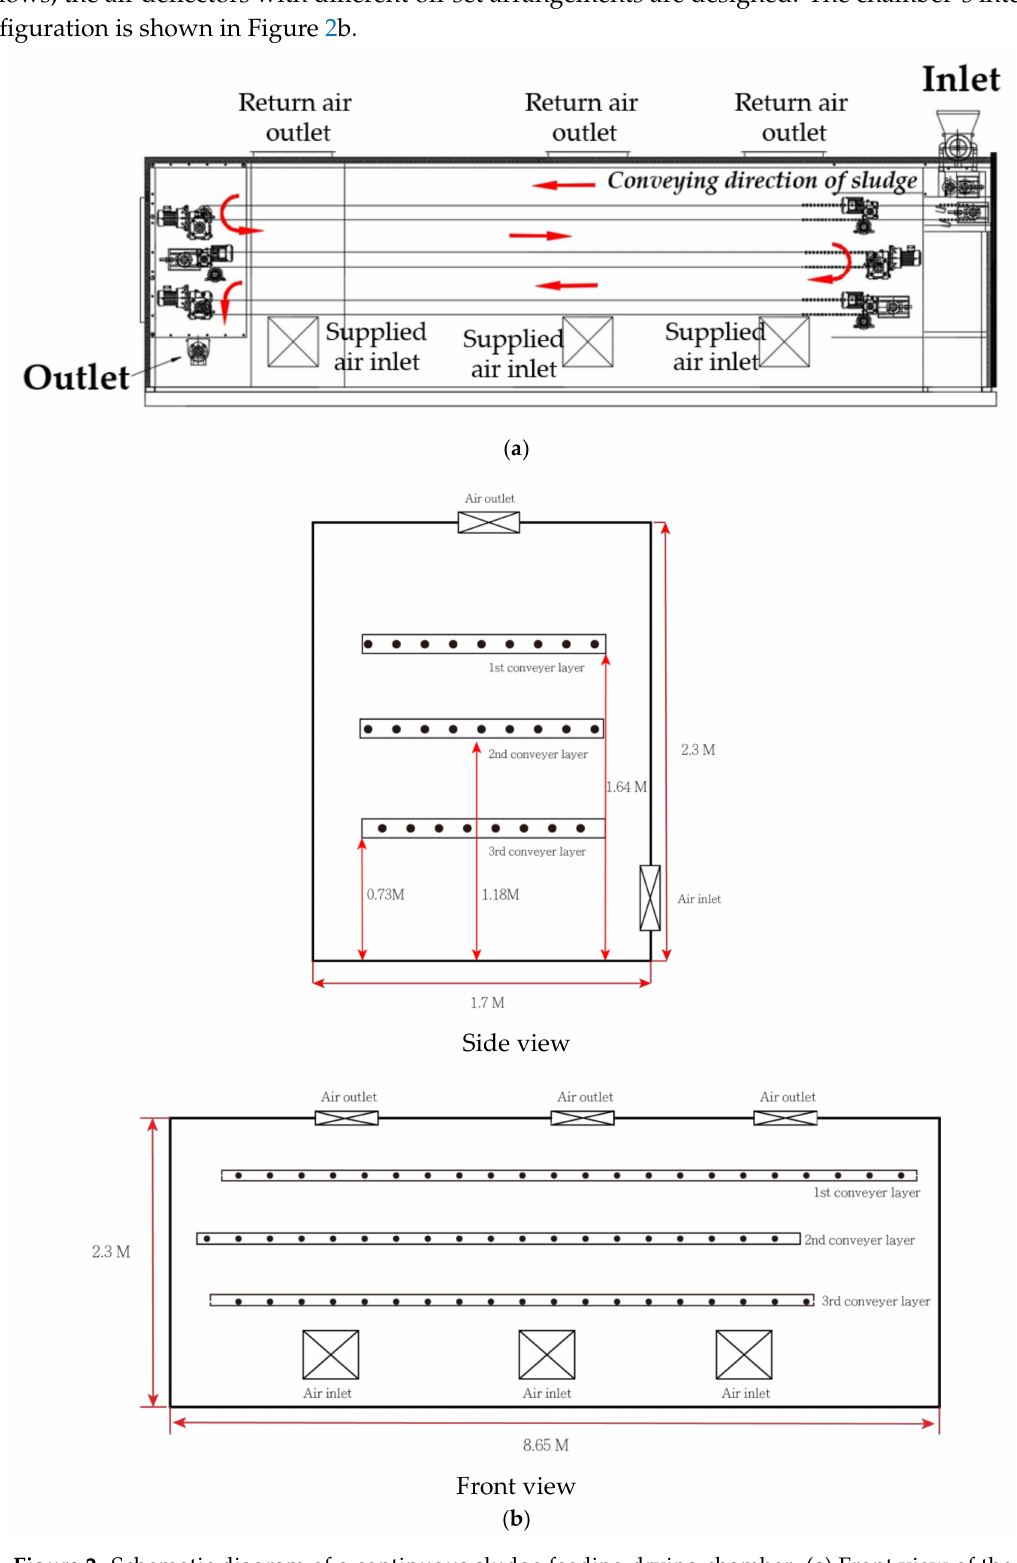
Figure 2. Schematic diagram of a continuous sludge feeding drying chamber. ( a ) Front view of the continuous sludge feeding drying chamber. ( b ) Internal configuration and air deflector design inside the drying